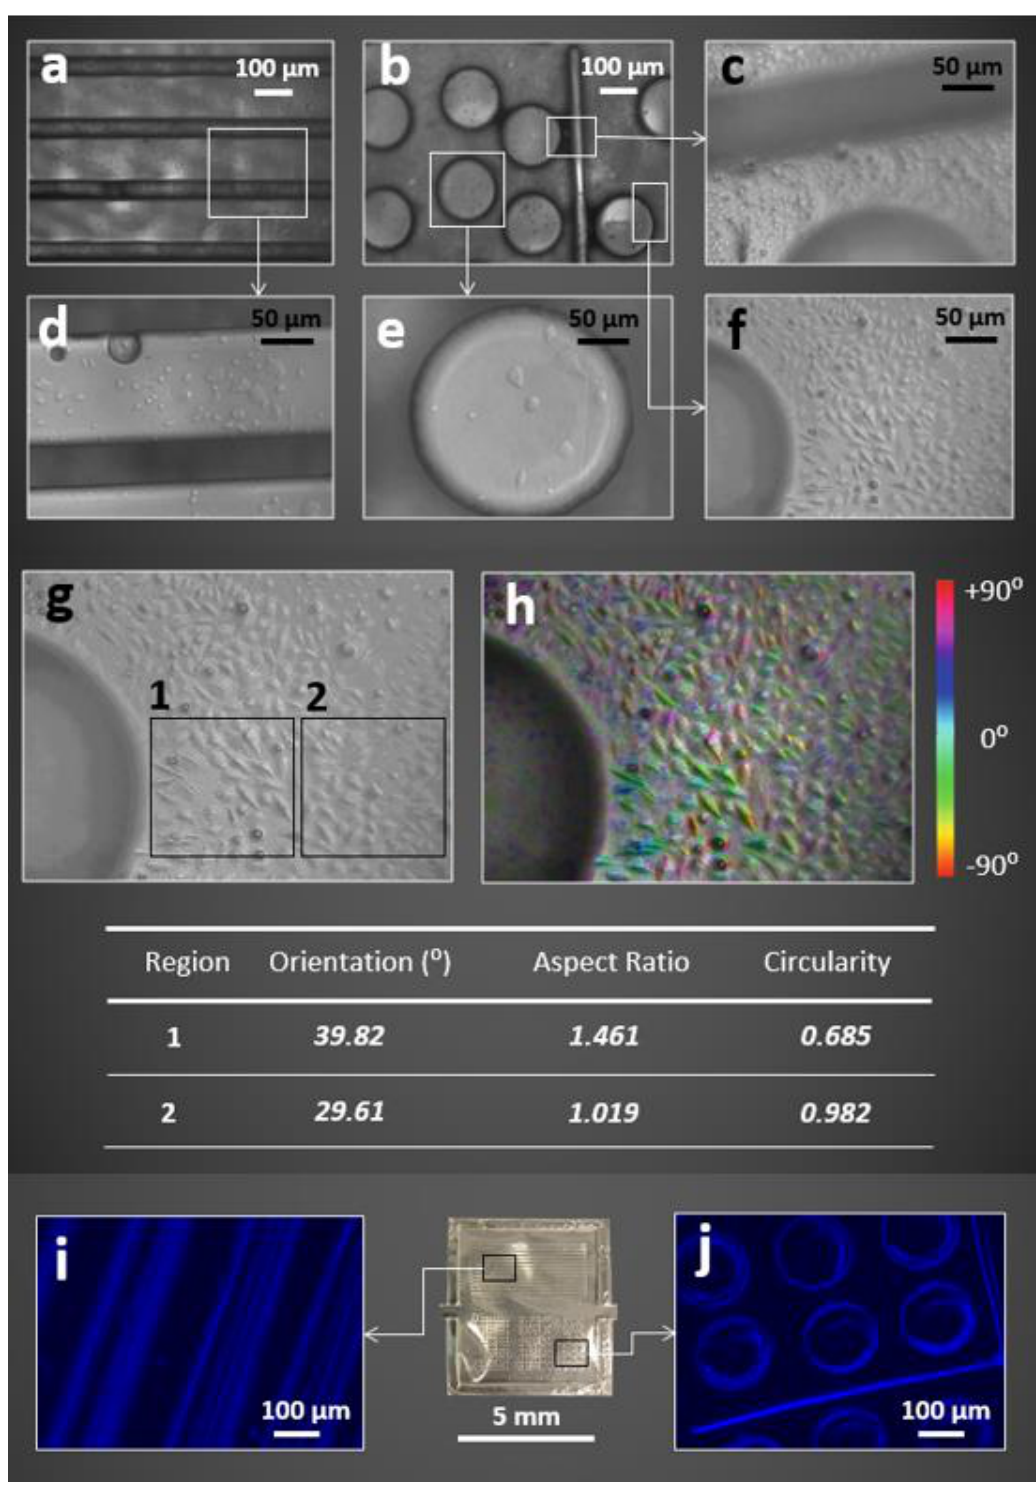
Figure 8. ( a – f ) Microscope images with different magnifications that were captured for different regions of the PVA + nanoprobe microchip in the cell culture media + L929 mouse cell media at their maximum swelling ratio. ( g ) A microscope image and ( h ) the corresponding image post-processing (ImageJ) to identify the impact of features on the orientation and shape of the cells. ( i , j ) Fluorescent microscope images of the microchip were captured from two different regions (denoted by black rectangles) of the microchip (middle camera image). In addition, we observed that the PAV + nano- probe microchip provided a suitable microenvironment for cell culture studies. It was found that cell directionality was tuned by the 3D microstructure ( h ), both cell orientation and aspect ratio were